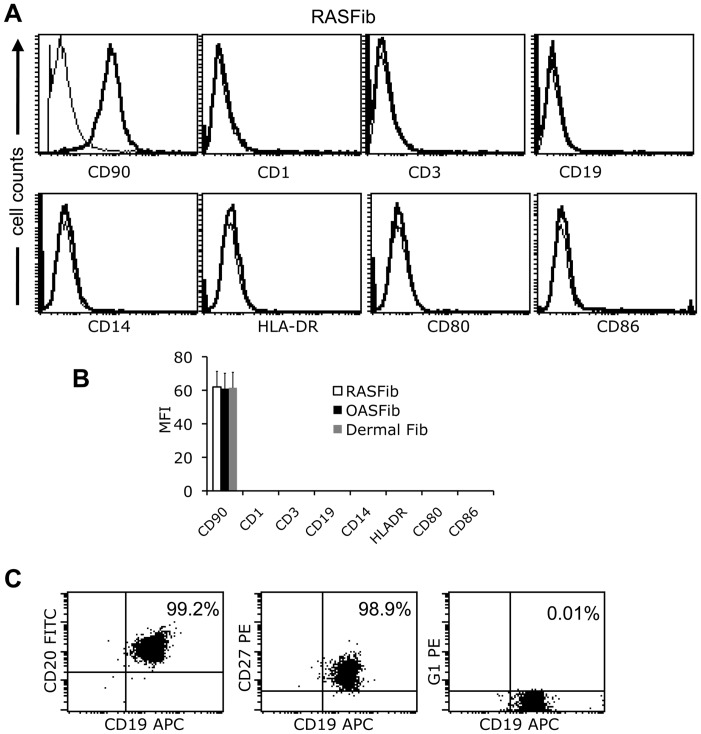
Characterization of cultured RASFib, OASFib and dermal fibroblasts (Third passage) and of freshly isolated memory B cells.
A. Representative flow cytometry histograms show staining of cultured RASFib (Third passage) with anti-CD90, anti-CD1, anti-CD3, anti-CD19, anti-CD14, anti-HLA-DR, anti-CD80 and anti-CD86 (Thick lines) or appropriate isotype controls (Thin lines). B. Bar histogram showing the MFI of RASFib (n = 10 lines), OASfib (n = 10 lines) or dermal fibroblasts (n = 5 lines) on the thrid passage, after staining with the antibodies mentioned in A. C. Representative flow cytometry dot plots after triple staining of isolated memory B cells with anti-CD20 FITC, anti-CD19 APC and anti-CD27PE or isotype control (gamma1) PE. Shown are two-dimension dot plots with different combinations of the above mentioned fluorochrome-labeled antibodies.